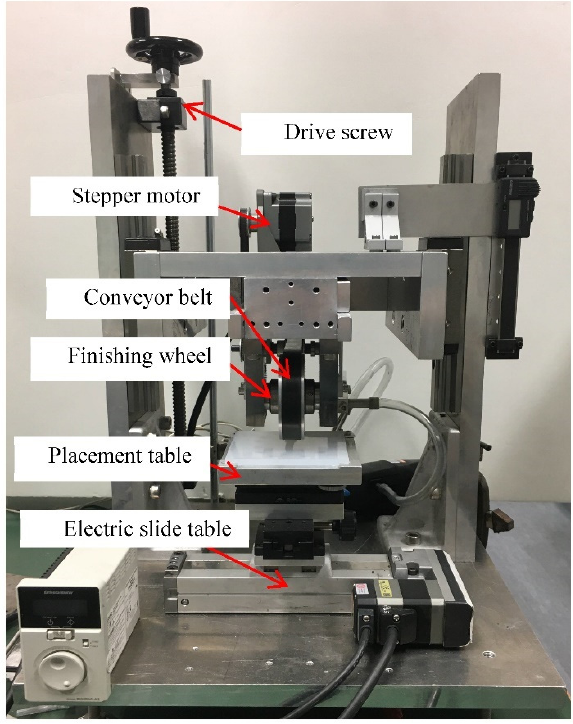
Figure 11. External view of the experimental device.